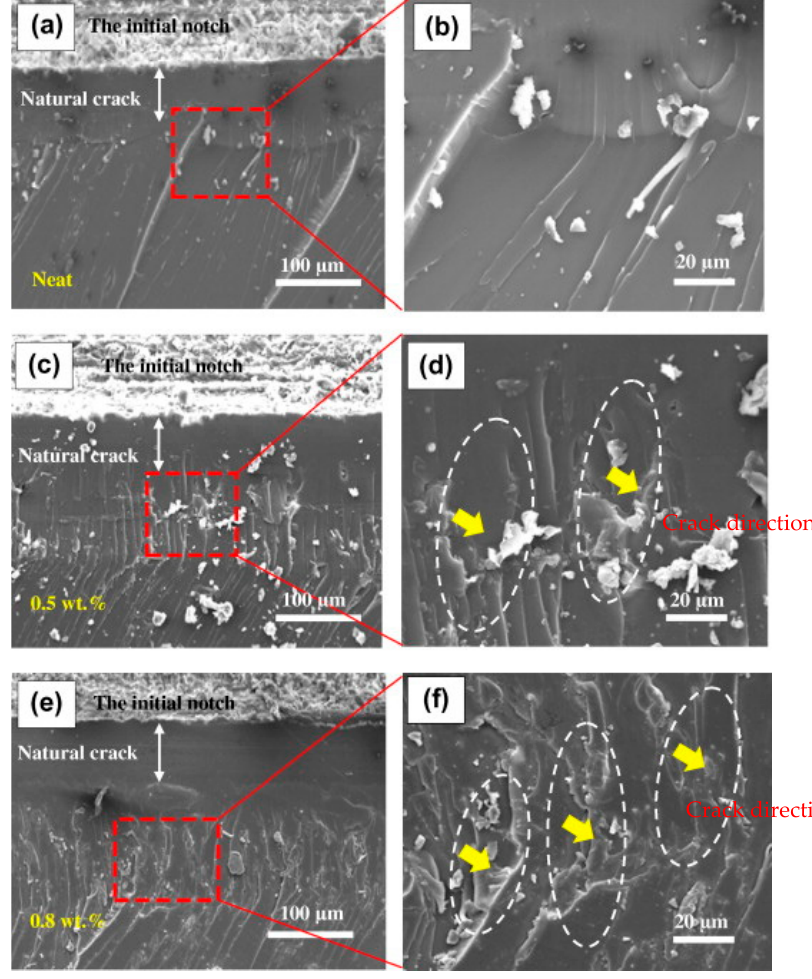
Figure 9. SEM analysis of fractured surfaces of pure epoxy: ( a , b ), 0.5 wt.% MBF ( c , d ) and 0.8 wt.% MBF ( e , f ) with the direction of crack propagation [168] (Reprinted/adapted with permission from Elsevier Ref.5457230729040 Copyright 2013.).